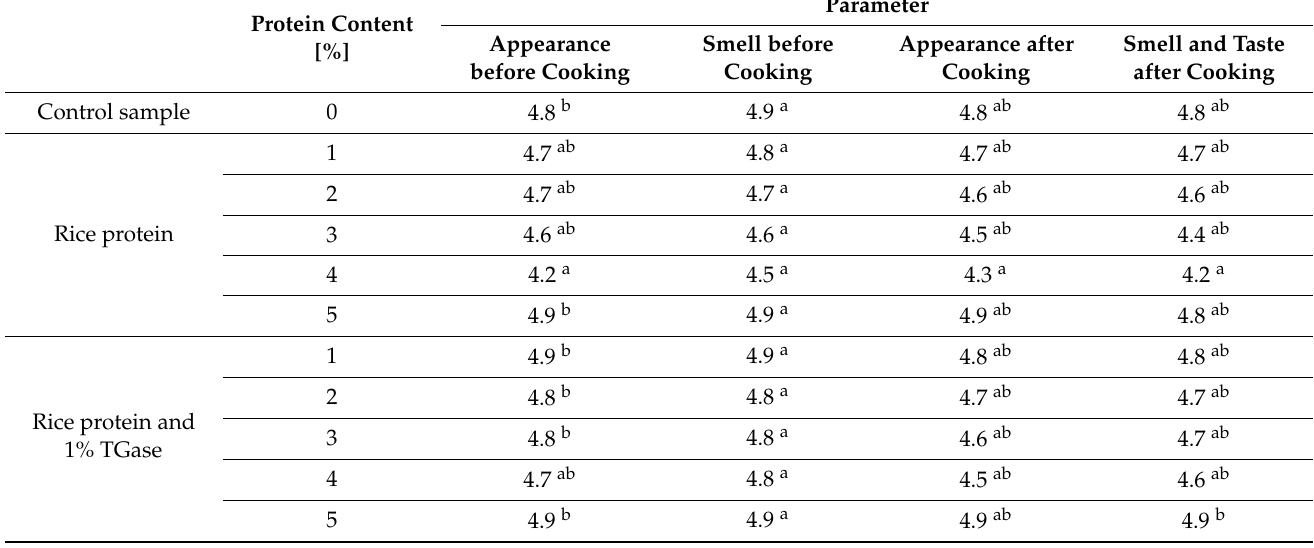
Table 4. Average values of the results of the sensory analysis of instant noodles with the addition of hemp protein and hemp protein and TGase. Mean values denoted by different letters ( a,b ) represent statistically significant differences between variables ( p <